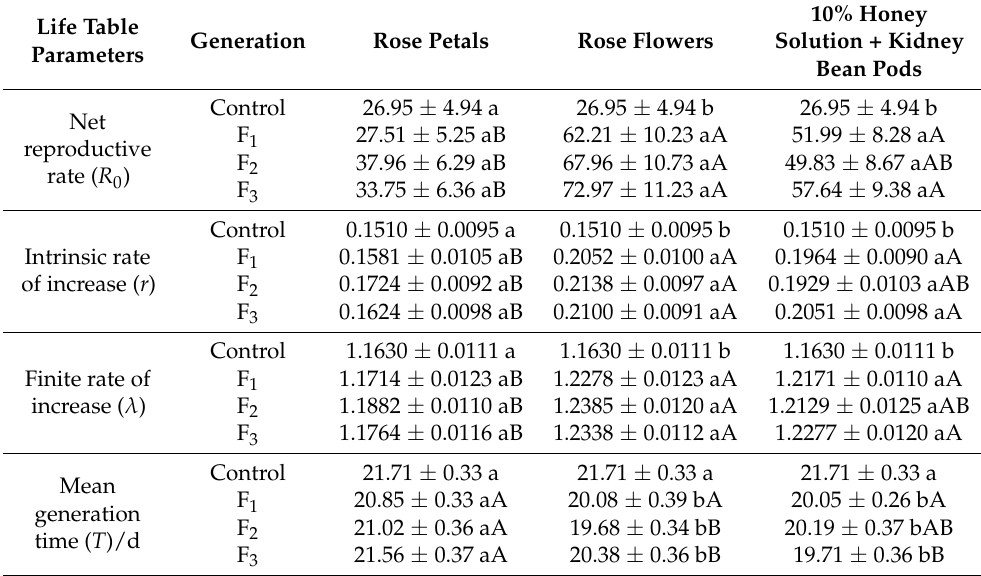
10% Honey Solution + Kidney Bean Pods